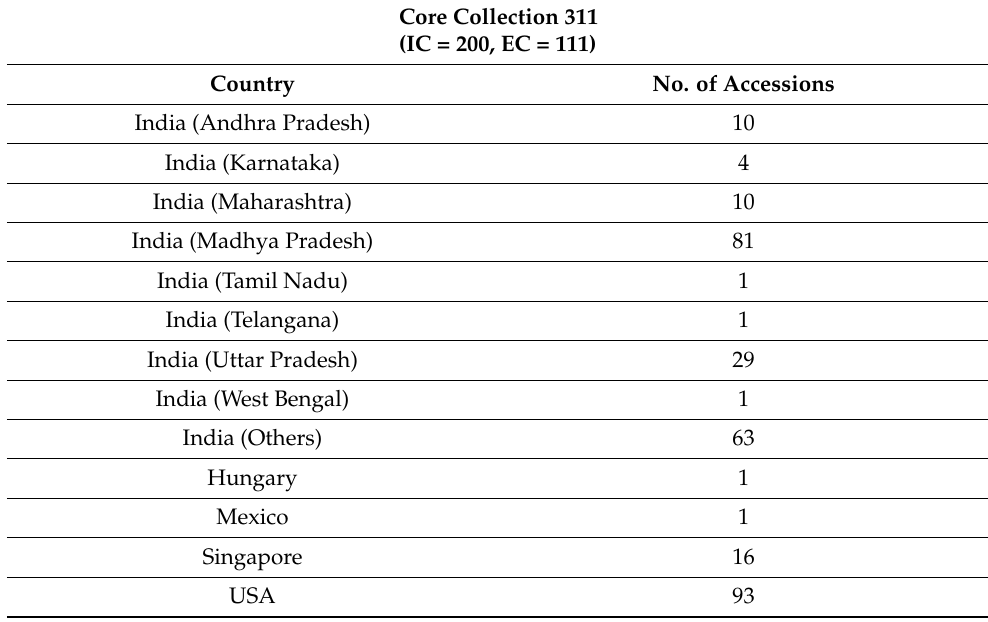
Table 6. Details of 311 safflower core